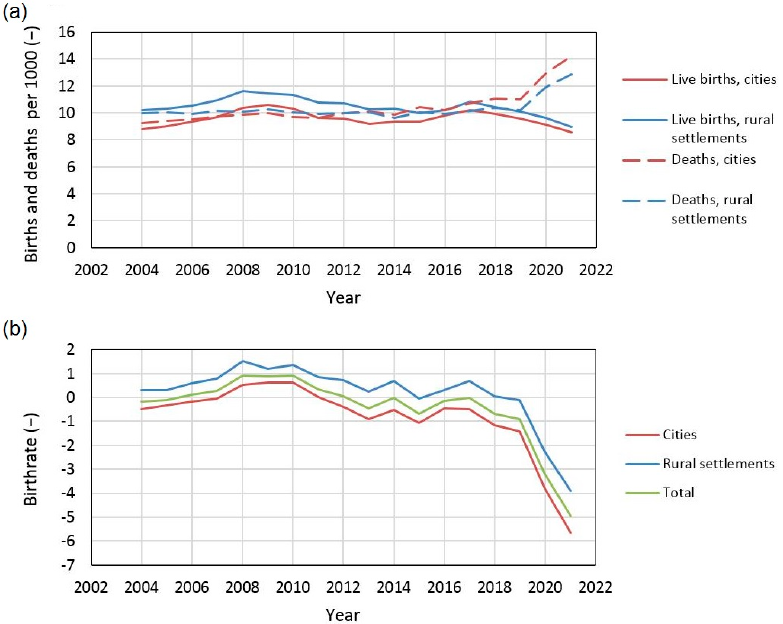
Figure 15. Population growth dynamics in Poland in 2002–2021, data obtained from [66]: ( a ) live births and deaths per 1000 residents for rural and urban populations, ( b ) birthrate in Poland.